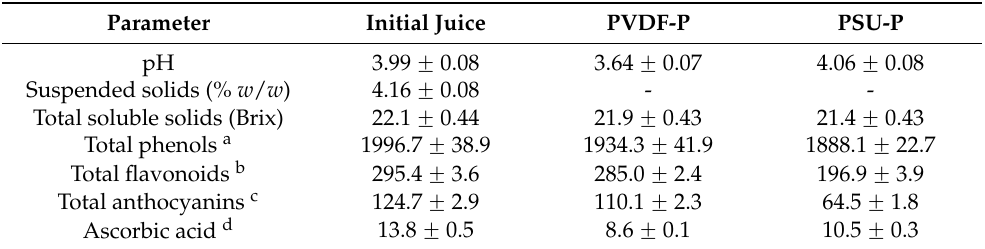
Table 3. Composition of pomegranate juice clarified by PVDF and PSU membranes. Parameter Initial Juice